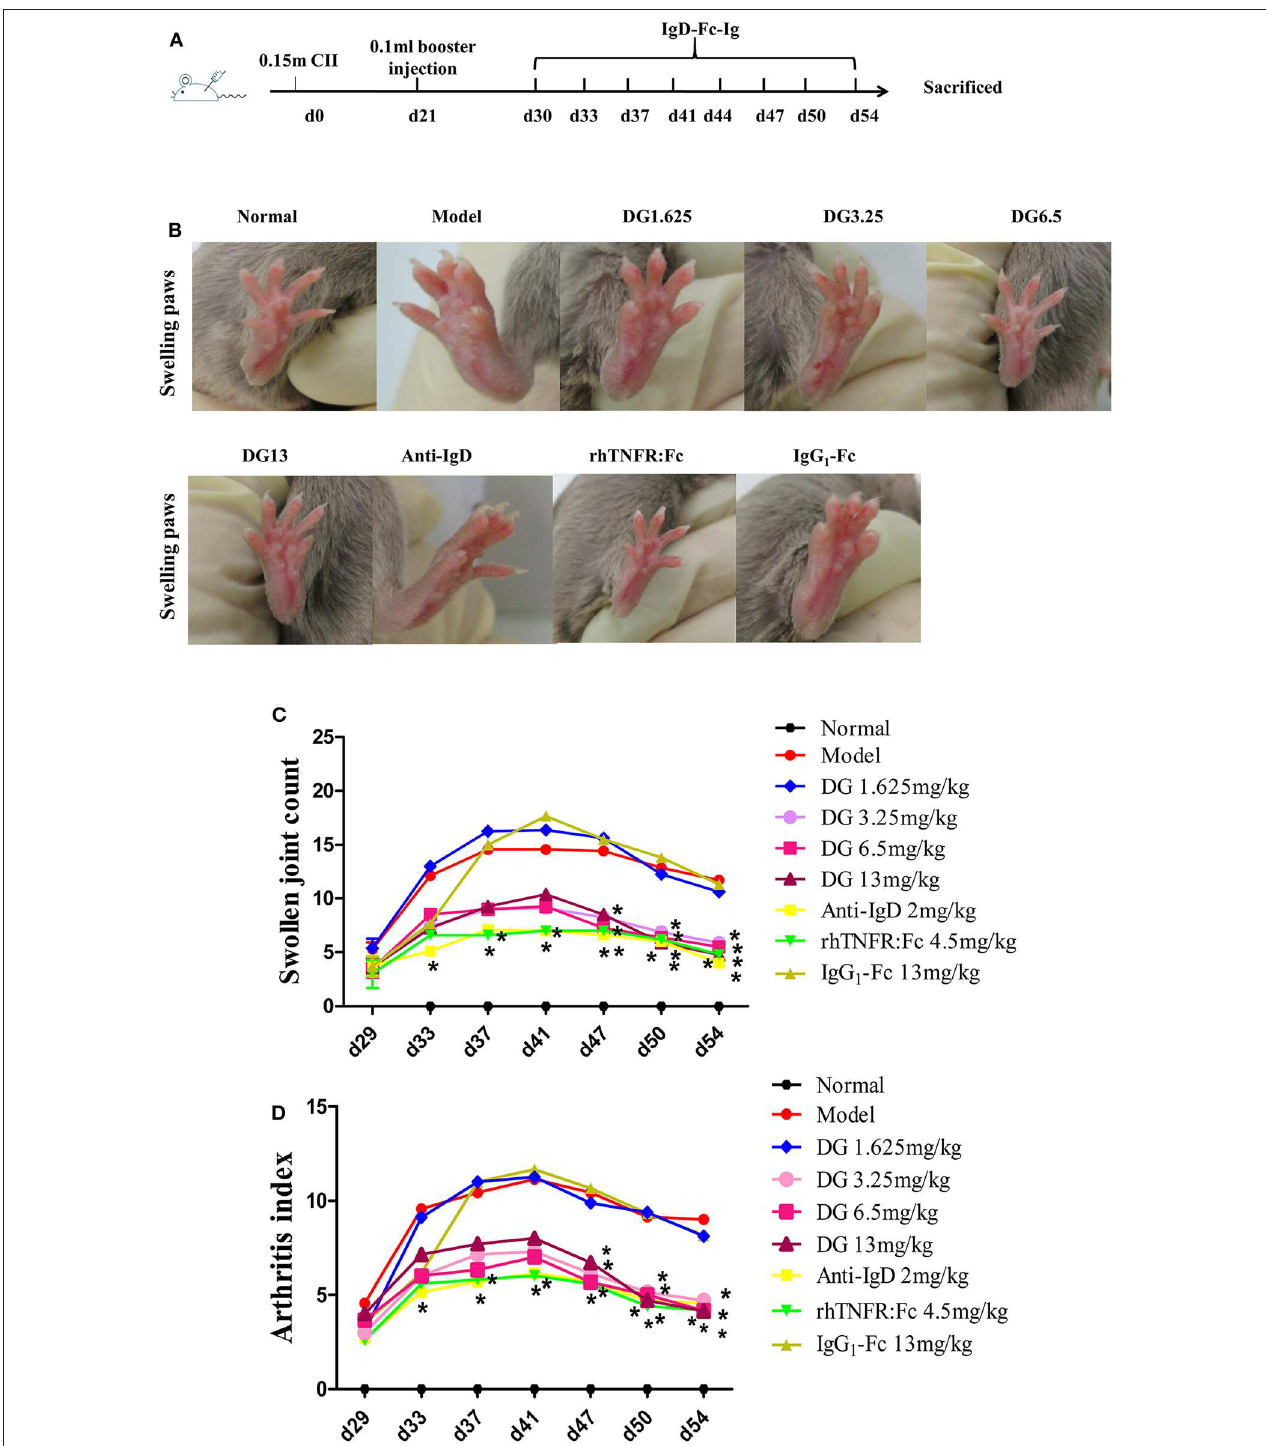
FIGURE 5 | Effects of IgD-Fc-Ig (DG) on swollen joint count and arthritis index of CIA mice. Anti-inflammatory effects of IgD-Fc-Ig (DG) on CIA mice. DBA/1 male mice were immunized with CII and FCA on D0 and D21. Then the mice were treated with IgD-Fc-Ig, IgG 1 -Fc, rhTNFR:Fc, and anti-mouse IgD antibody by tail intravenous administration. (A) The time points of IgD-Ig-Fc fusion protein administrated. (B–D) Effects of IgD-Fc-Ig on swollen joint count and arthritis index of CIA mice. * P < 0.05 vs. Model.